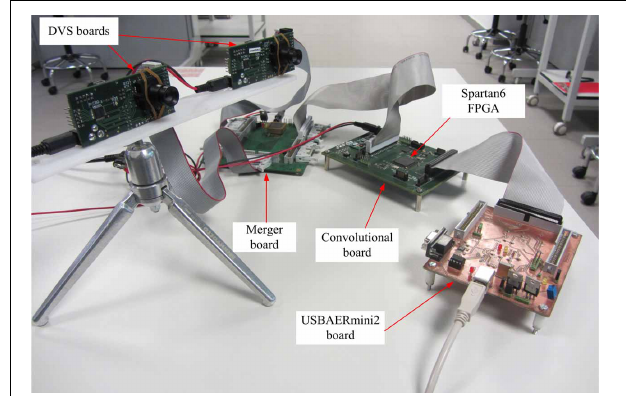
FIGURE 5 | Experimental stereo setup.